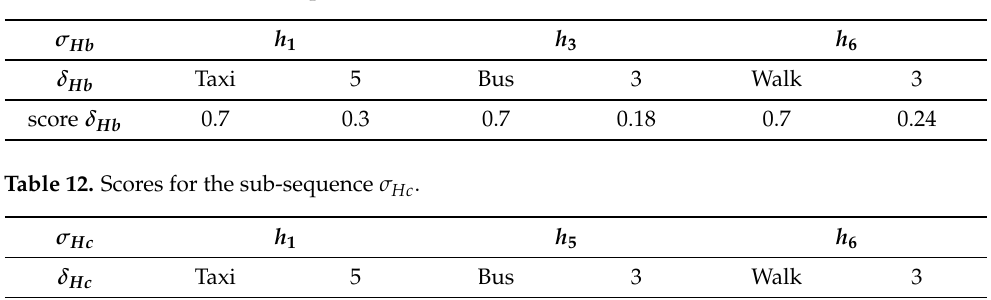
Table 11. Scores for the sub-sequence σ Hb .